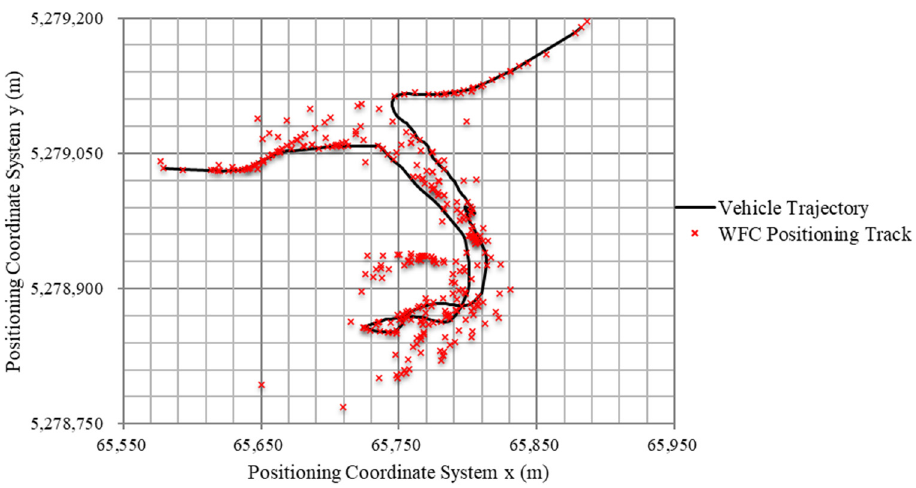
Figure 10. WFC fusion method trajectory.